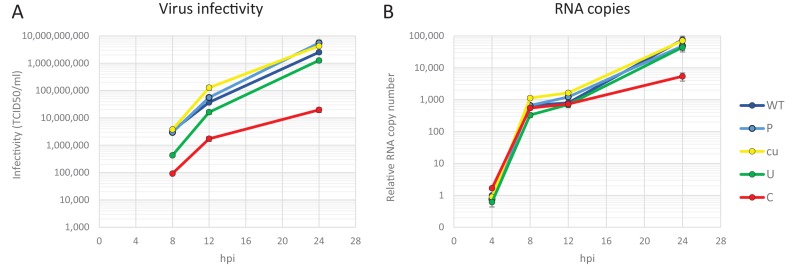
Replication of E7 virus with increased CpG dinucleotides is restricted immediately upon entry delaying replication rates.RD cells were infected with E7 at equal infectivity (MOI 0.01). In these viruses, coding region 2 (R2) was either of wild type (WT), permutated (P), CpG and UpA low (cu), UpA high (U) or CpG high (C) composition. Infectivity of progeny virus was determined in EPDA (A). RNA copies were determined by quantitative RT-PCR on total RNA and are presented relative to WT E7 at one hpi (B). Data points represent the mean of three independent experiments and error bars one standard error of the mean.